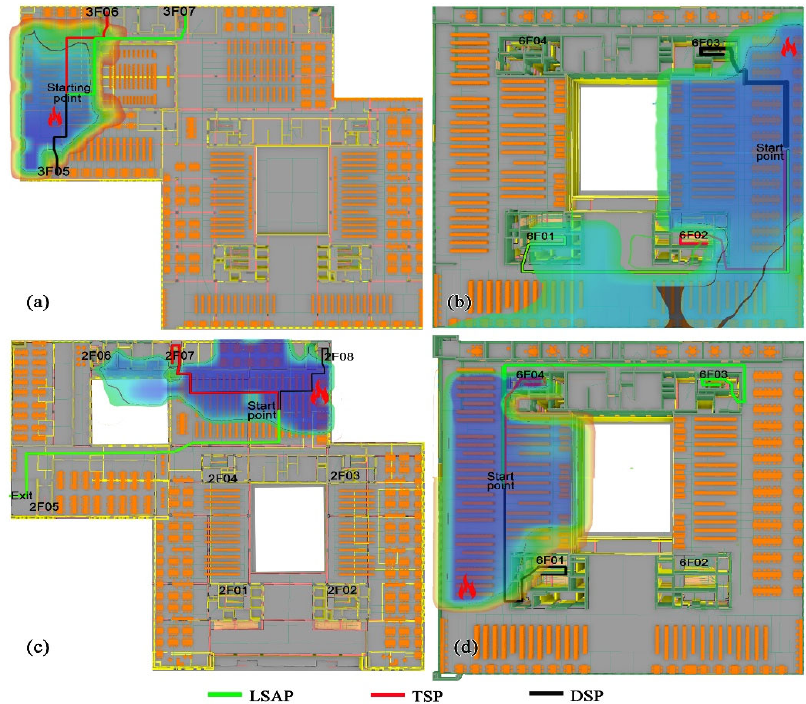
Figure 8. Spatial differences between evacuation passageways across the four seasons: ( a ) spring; ( b ) summer; ( c ) autumn; and ( d ) winter. Table 9. Comparative analysis of the parameters for different evacuation passageways in